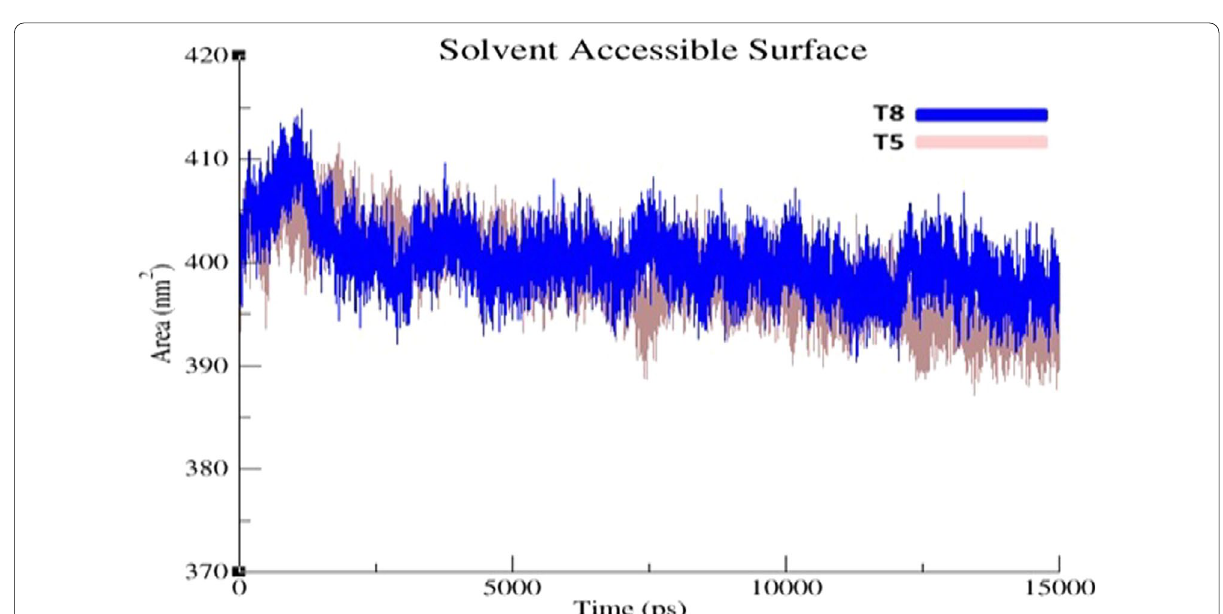
Fig. 7 Solvent‑accessible surface area (SASA) graph of T5 and T8 targeted protein at different time scales from 0 to 15,000